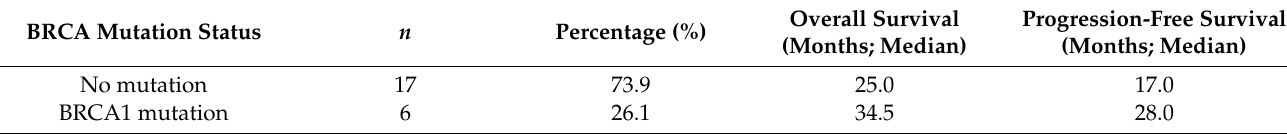
Table 2. Patient characteristics of the blood